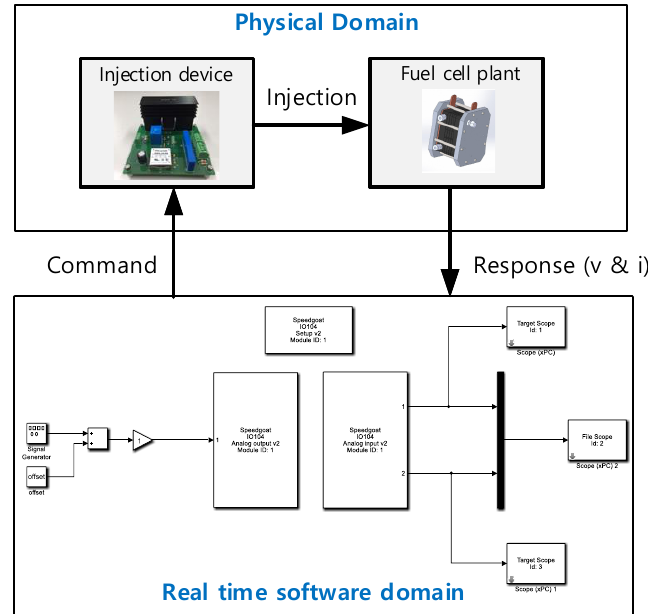
Figure 8. Real-time control by target machine with fuel cell system .